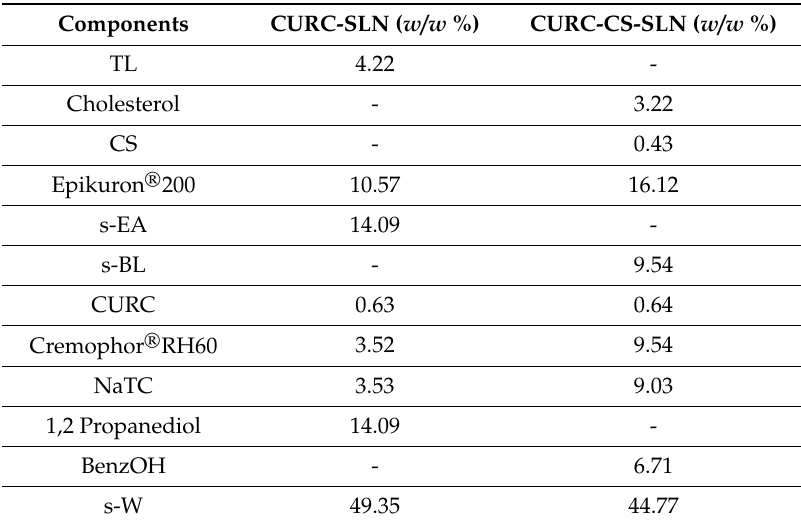
Table 1. Compositions of the CURC-loaded SLNs